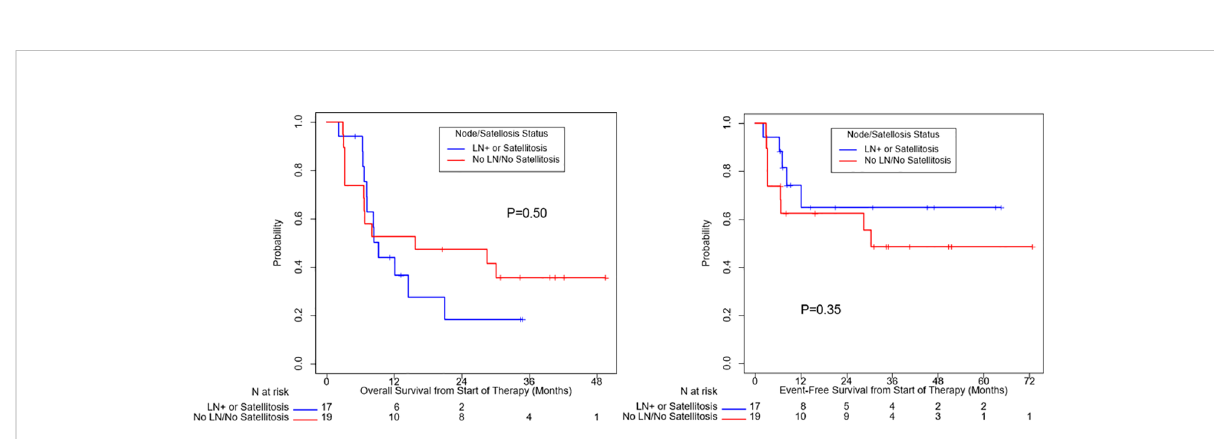
FIGURE 3 Overall survival and event free survival strati fi ed based on regional nodal or satellite involvement and localized disease only.